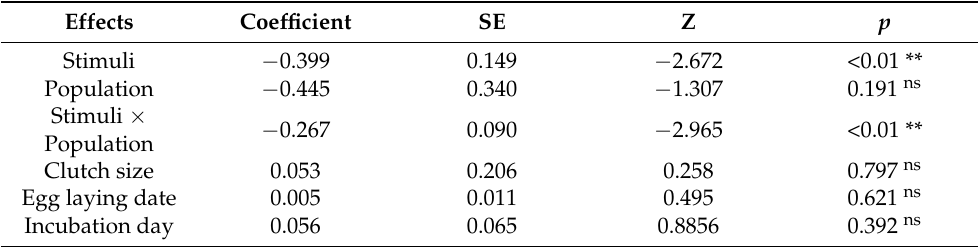
Table 2. The result of Cox regression controlling for nest identity in this study.